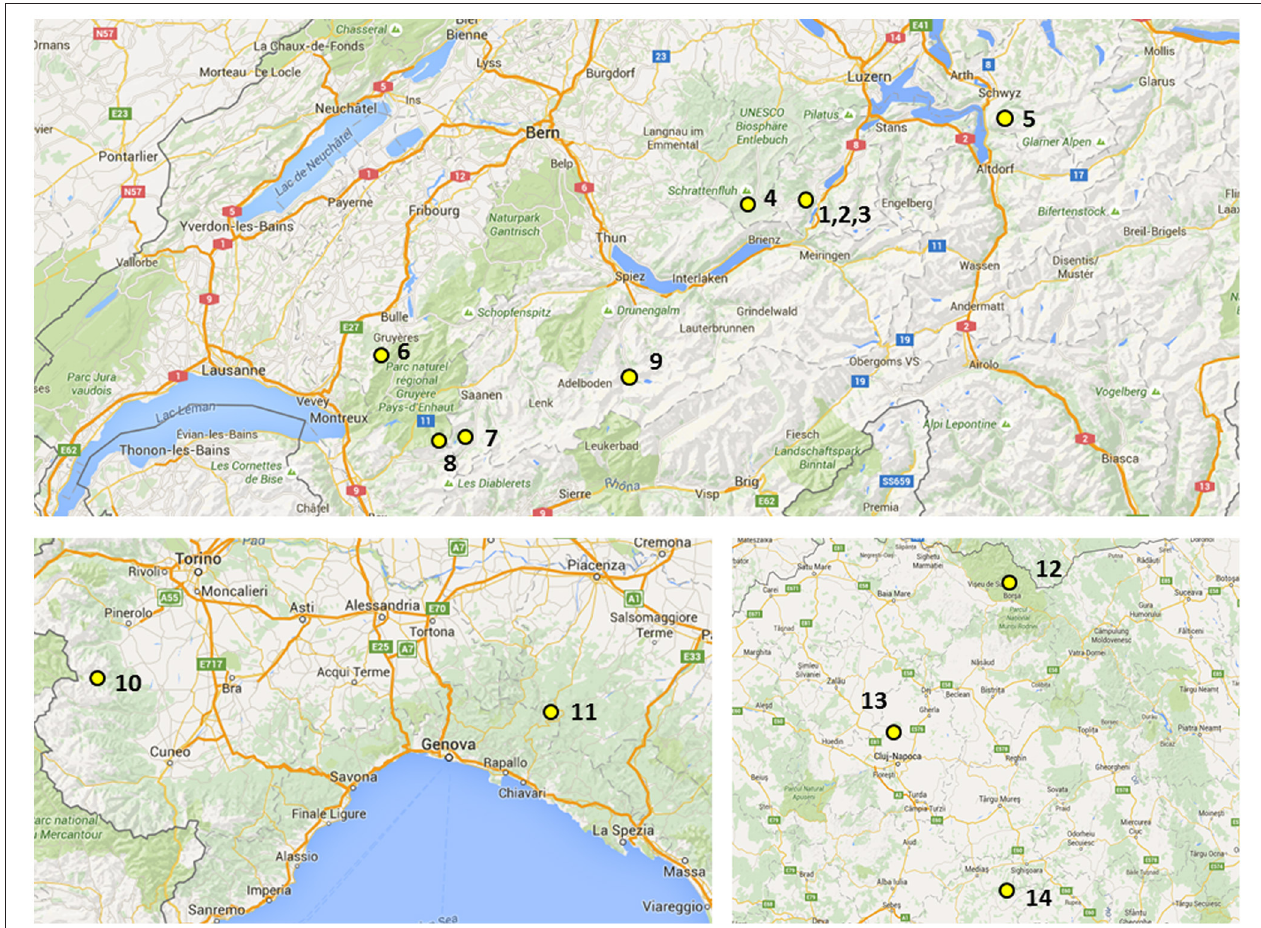
FIGURE 1 | Geographical distribution of localities in Switzerland (up), Italy (bottom, left), and Romania (bottom, right): (1) Mörlialp, (2) Glaubenbielen, (3) Fontanen (4) Küblisbiehlschwand, (5) Stoos, (6) Moleson, (7) Gsteig, (8) La Para, (9) Kandersteg, (10) Crisollo, (11) Santo Stefano d’−Aveto, (12) Baile Borsa, (13) Borsa, and (14) Nou